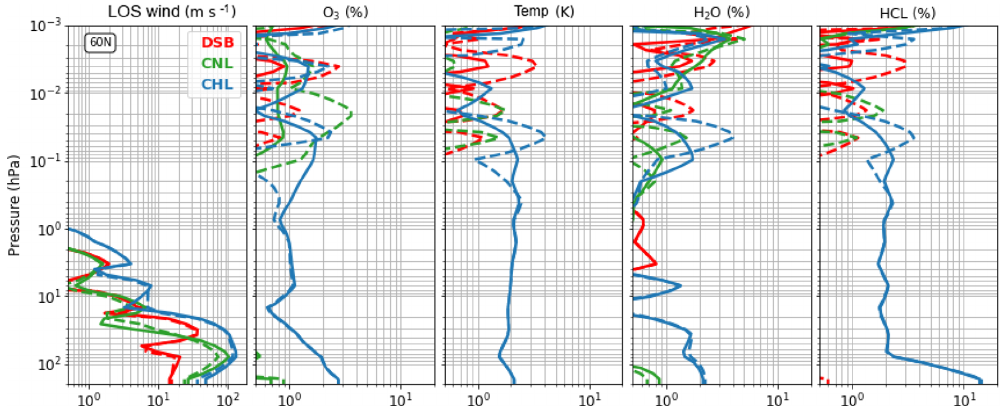
Figure 11. Same as Fig. 10 but for double-sideband ratio (DSB), radiometer nonlinearity (CNL) and calibration hot-load emission (CHL). The error assumptions are summarized in Table